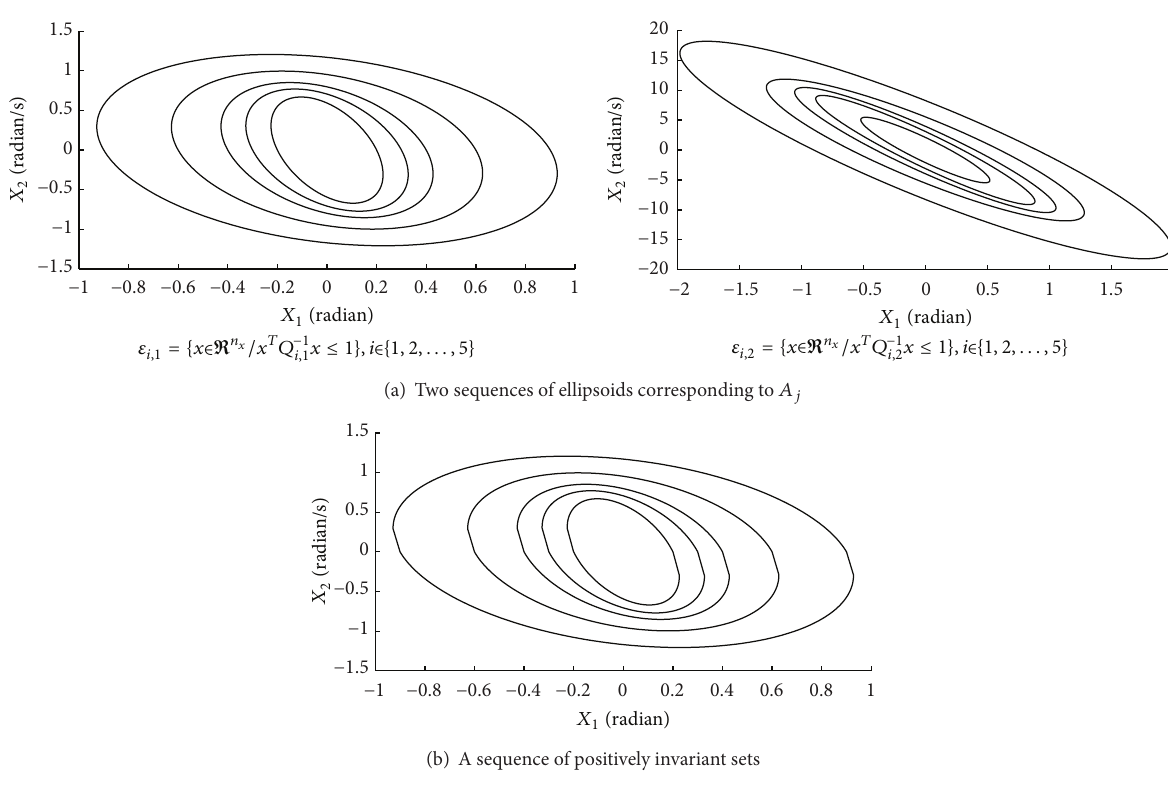
Figure 3: The ellipsoids computed offline in Example 2 (a) two sequences of ellipsoids corresponding to 𝐴 𝑗 and (b) a sequence of positively invariant sets.